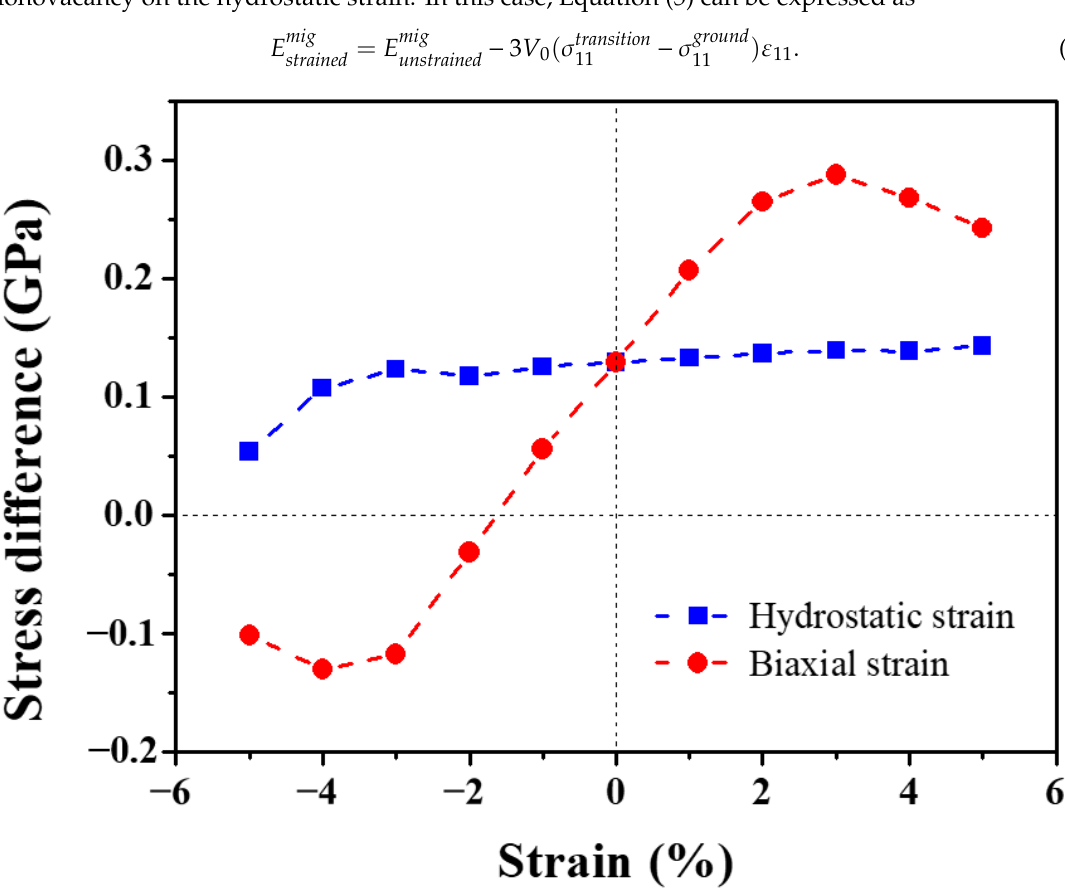
Figure 7. The stress difference between the transition and ground states along the strained direction for hydrostatically (blue dashed line) and biaxially (red dashed line) strained system.